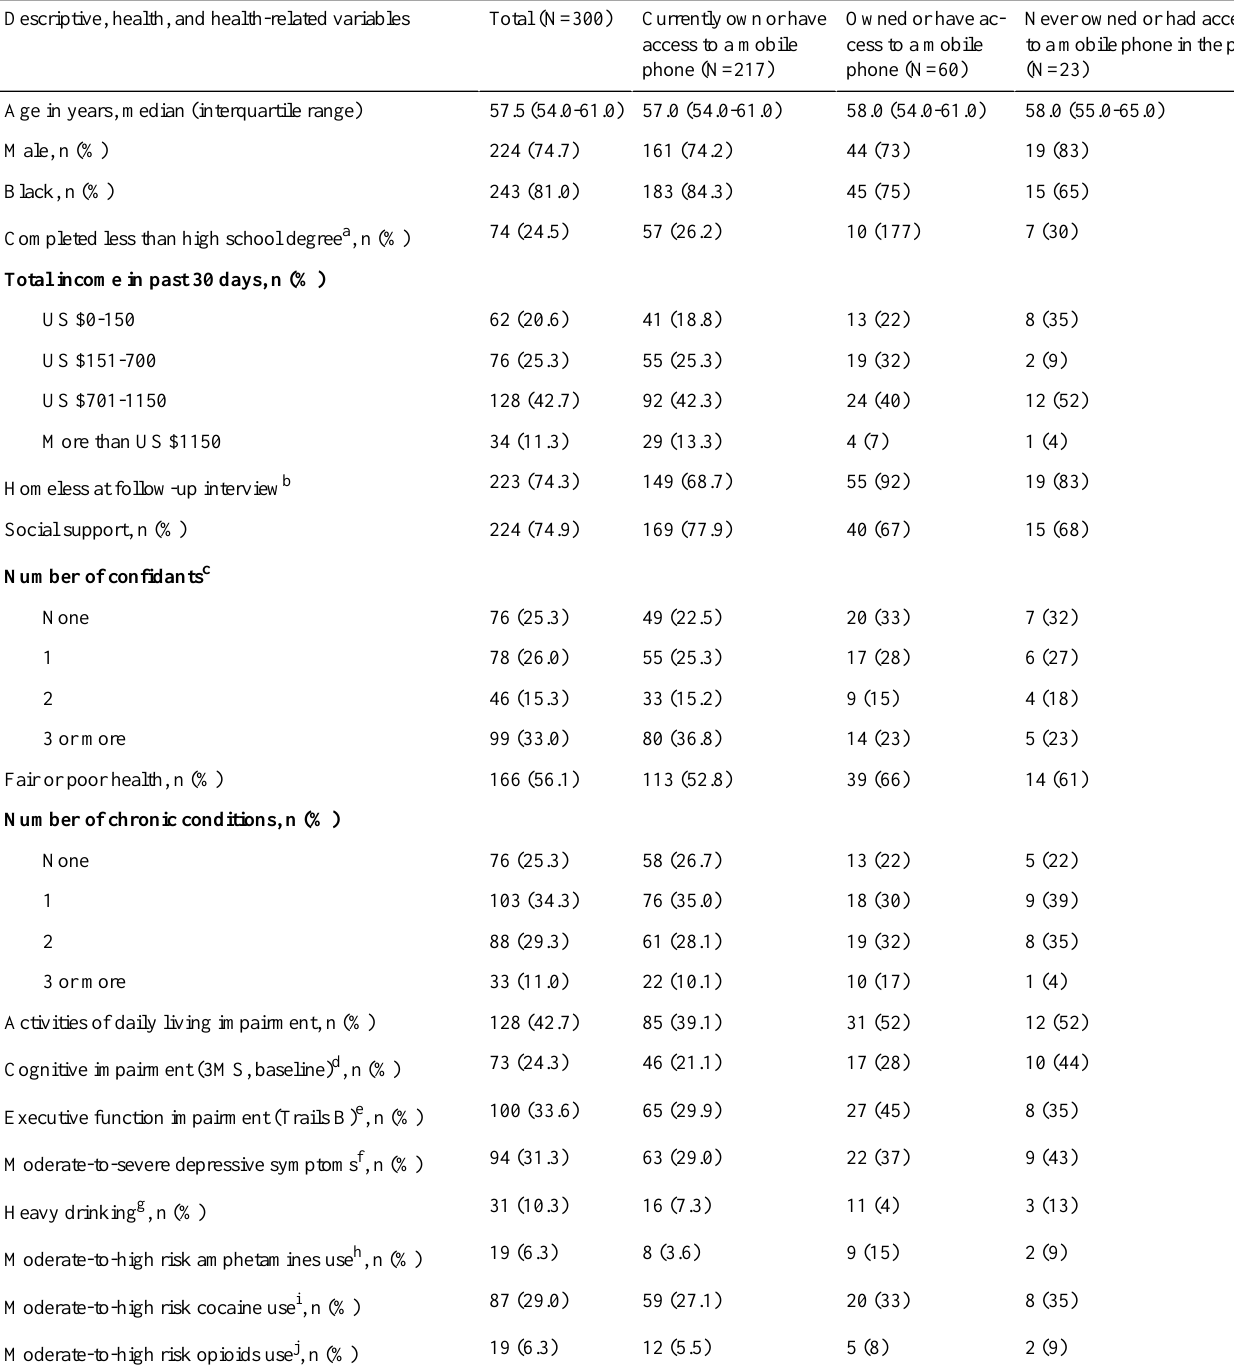
Table 1. Participant characteristics of mobile phone use.